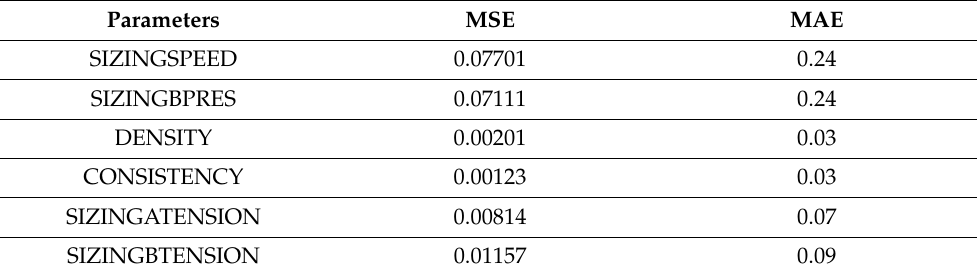
Table 14. Elastic Net results for the sizing process.